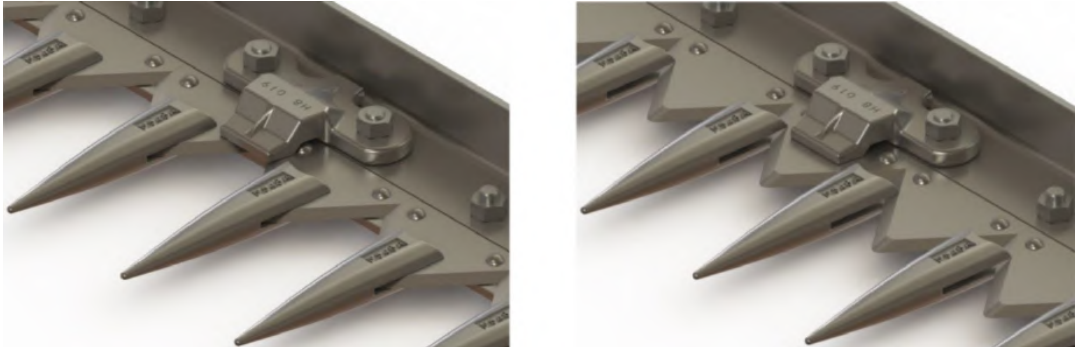
Figure 5. Limit positions of the blades.